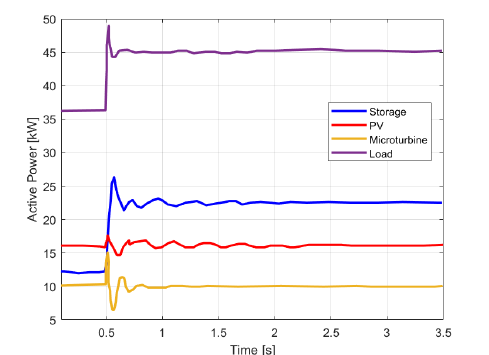
Figure 7. Simulation A: Active Power.